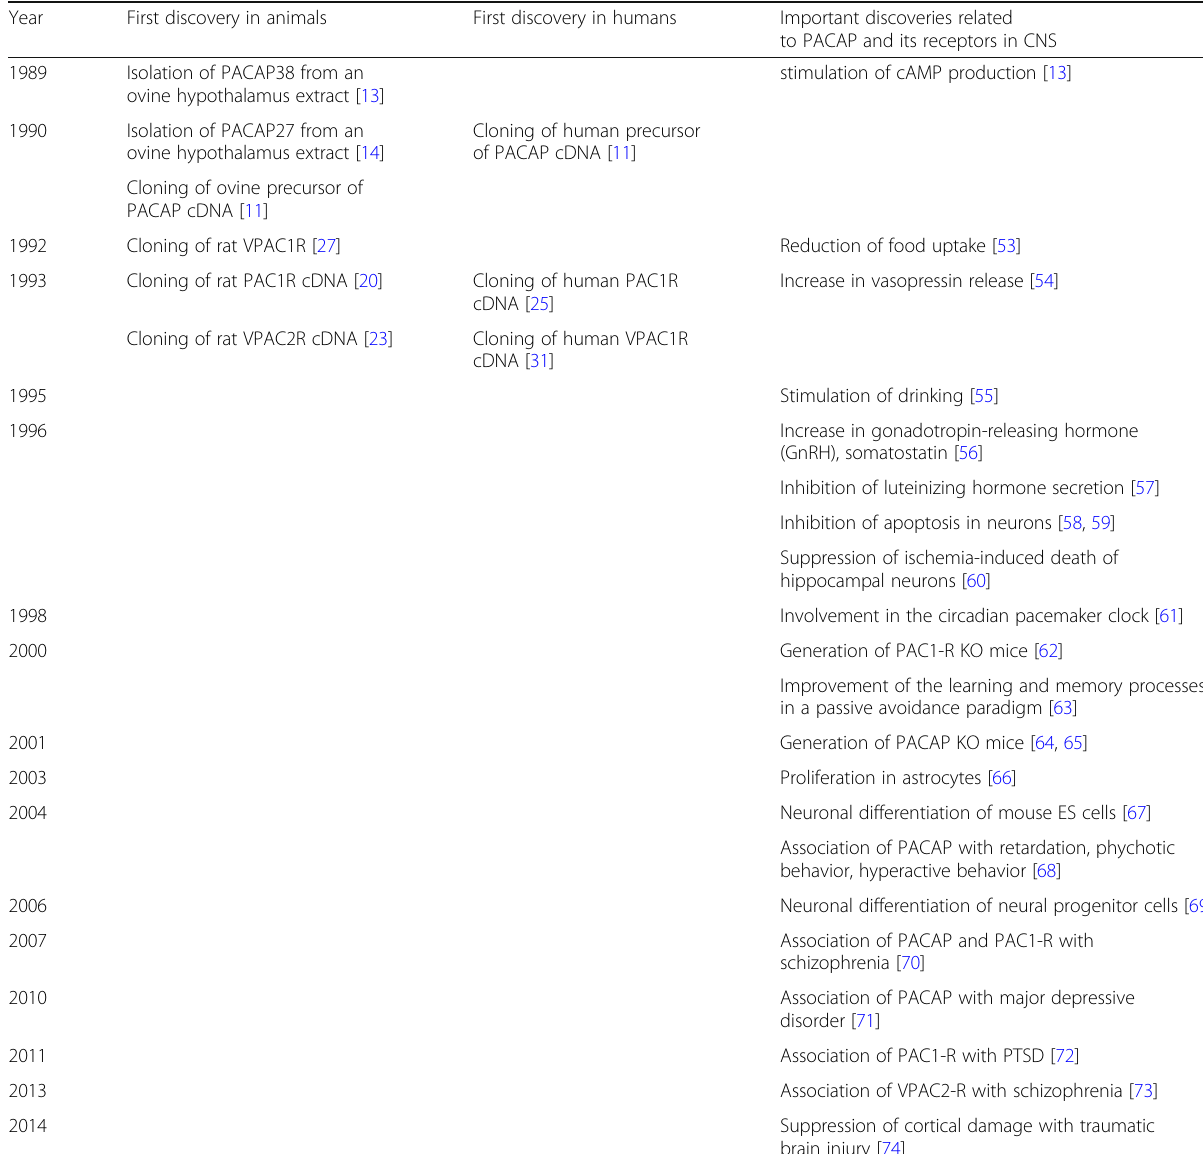
Table 1 A historical table of important discoveries related to effects of PACAP and its